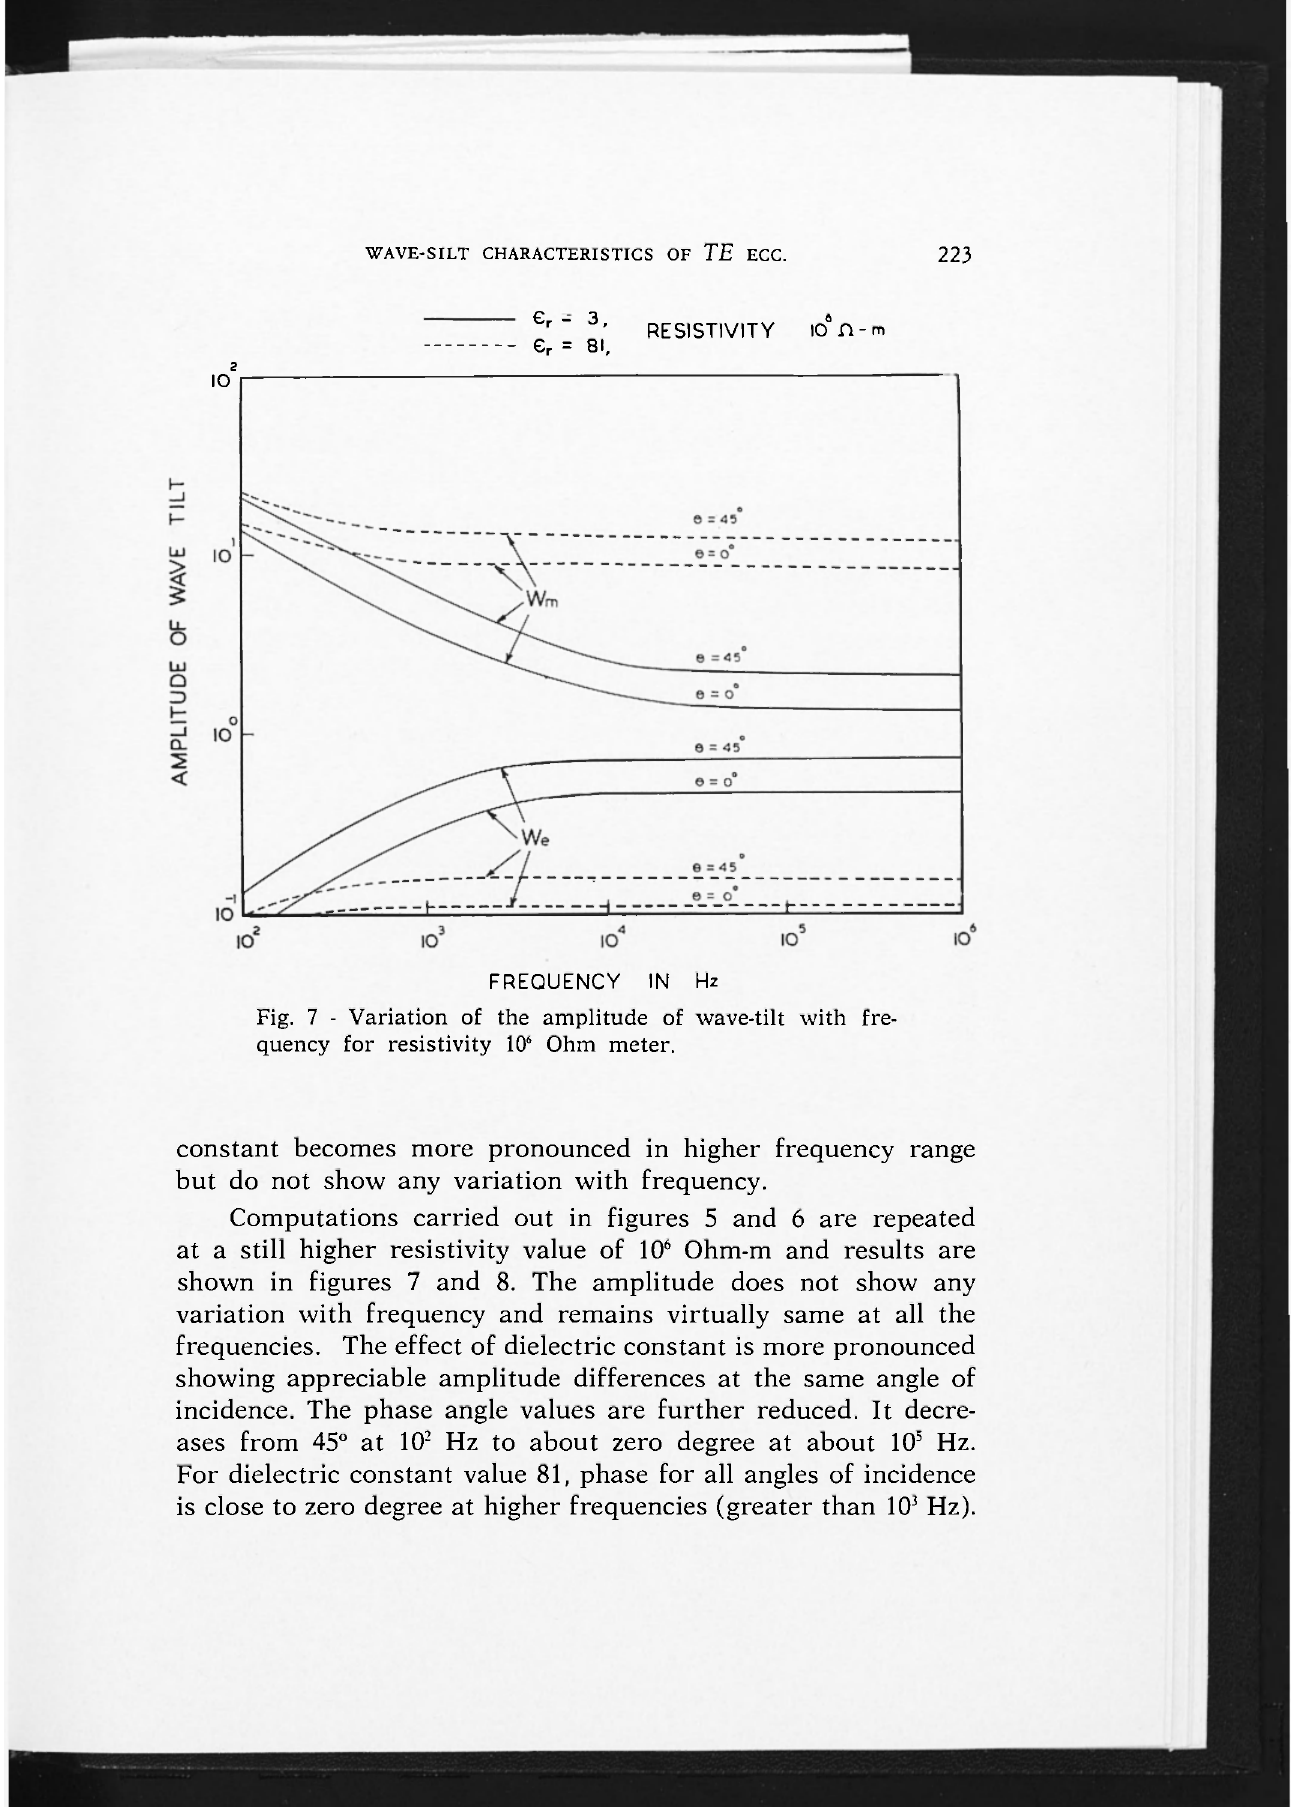
Fig. 7 - Variation of the amplitude of wave-tilt with fre- quency for resistivity 10 6 Ohm